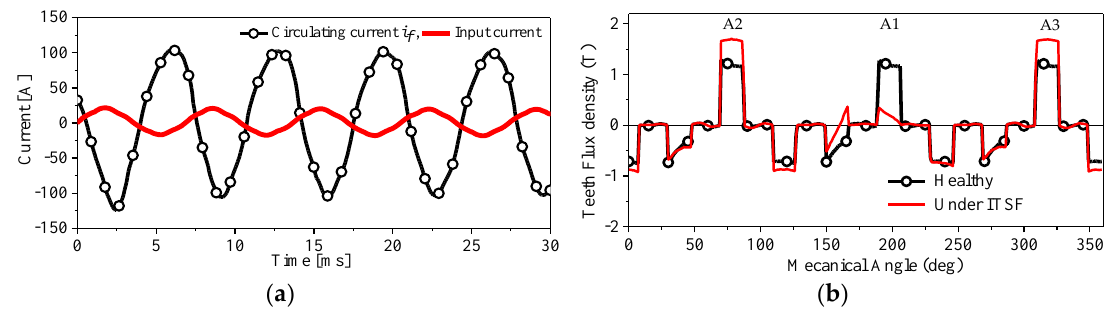
Figure 2. ( a ) Stator input current and the circulating/fault current under ITSF; ( b ) Magnetic flux density in teeth of Phase-A under healthy and ITSF conditions.